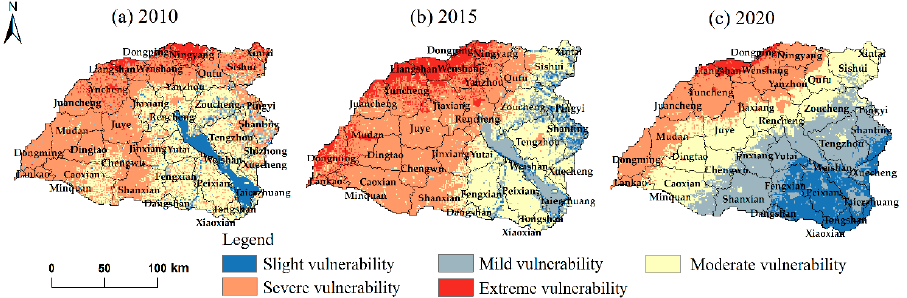
Figure 2. Spatial distribution of standardized ecological vulnerability index in Nansi Lake Basin in Table 5. The results of comprehensive ecological vulnerability index.